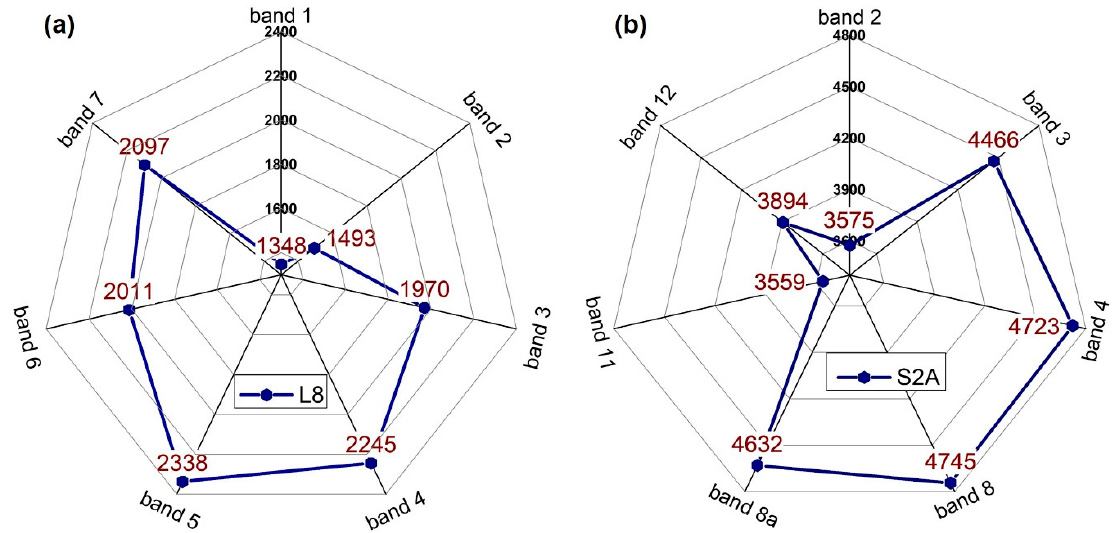
Figure 8. Landsat-8 ( a ) and Sentinel-2A ( b ) dataset bands and the numbers of auto-extracted lineaments.